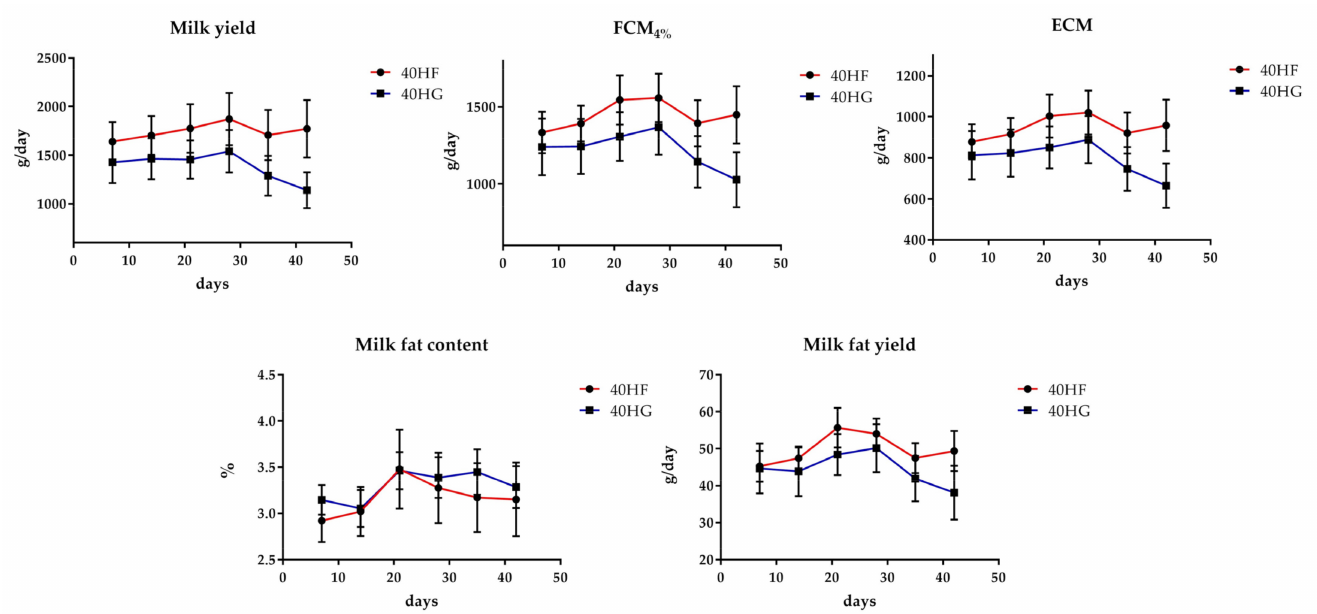
Figure 2. Mean milk performance of goats fed diets with 40 g Schizochytrium spp. and two different forage to concentrate ratios (40 HF; red line and 40 HG; blue line) throughout the experimental period. Error bars represent the standard error of the means (SEM). 40 HF: 40 g Schizochytrium spp. and high forage diet (60:40); 40 HG: 40 g Schizochytrium spp. and high grain diet